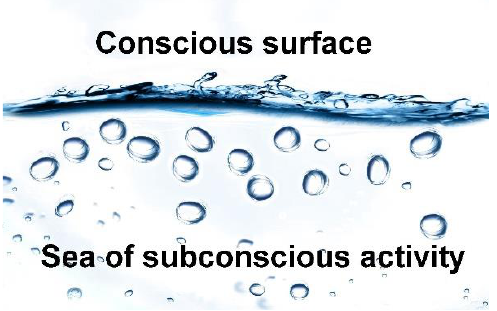
Figure 4. Meditation. The nonconscious brain normally sends a lot of bubbles to fuse at the conscious surface. Meditative techniques reduce this flow. By calming the mind, it becomes more accessible to exercise.